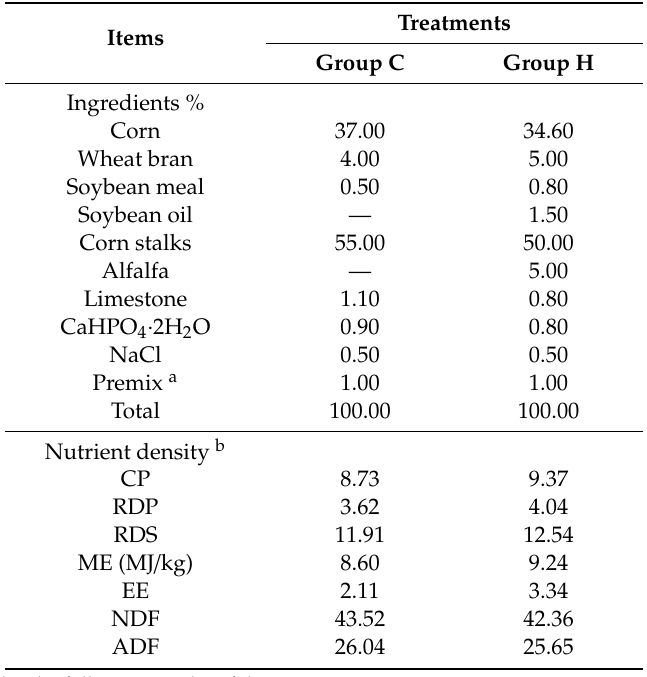
Table 1. Composition and nutrient contents of the experimental diets (DM